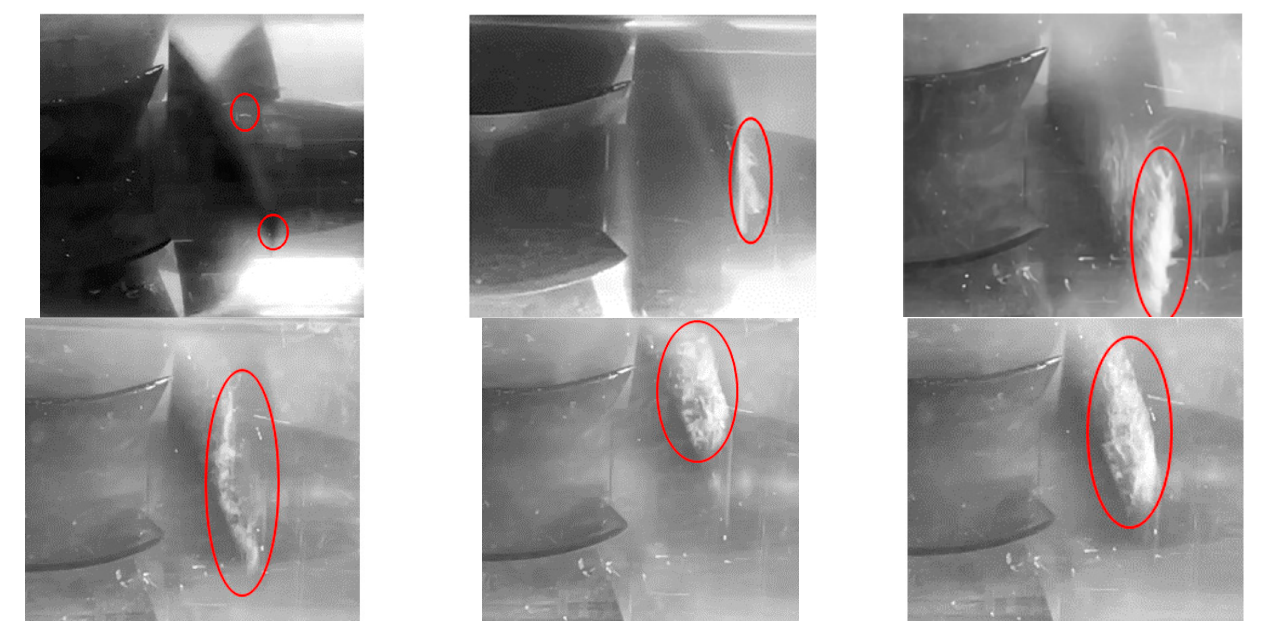
Figure 17. Acceleration scheme 2.